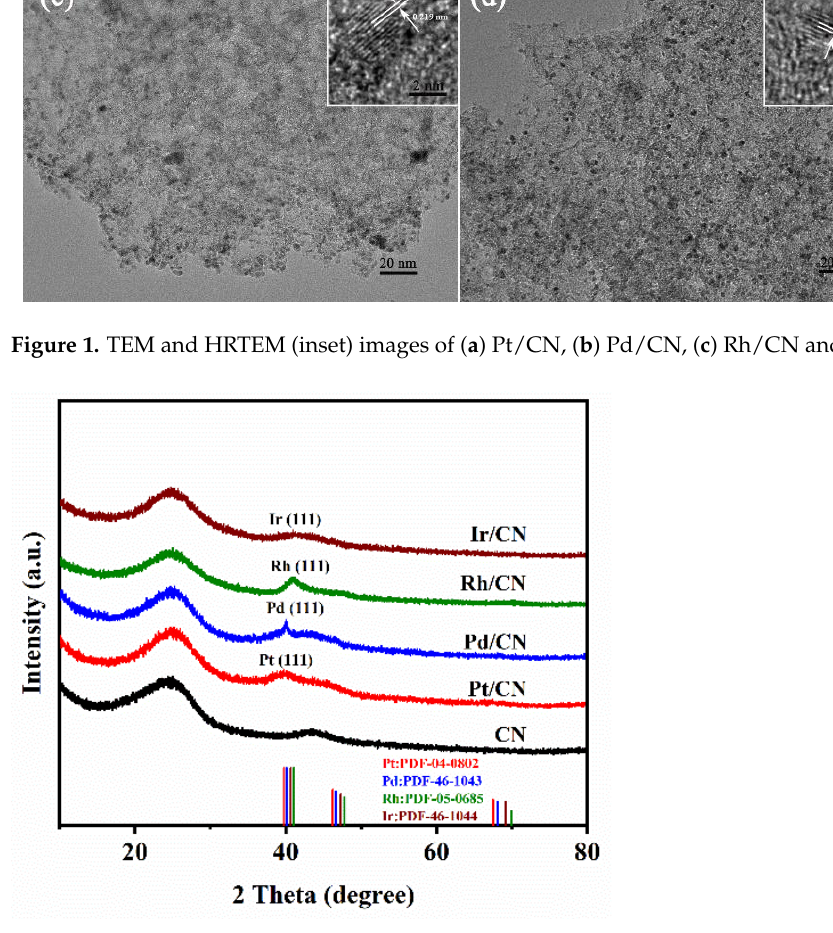
Figure 2. The XRD patterns of the CN support and M/CN (M = Pt, Pd, Rh and Ir)